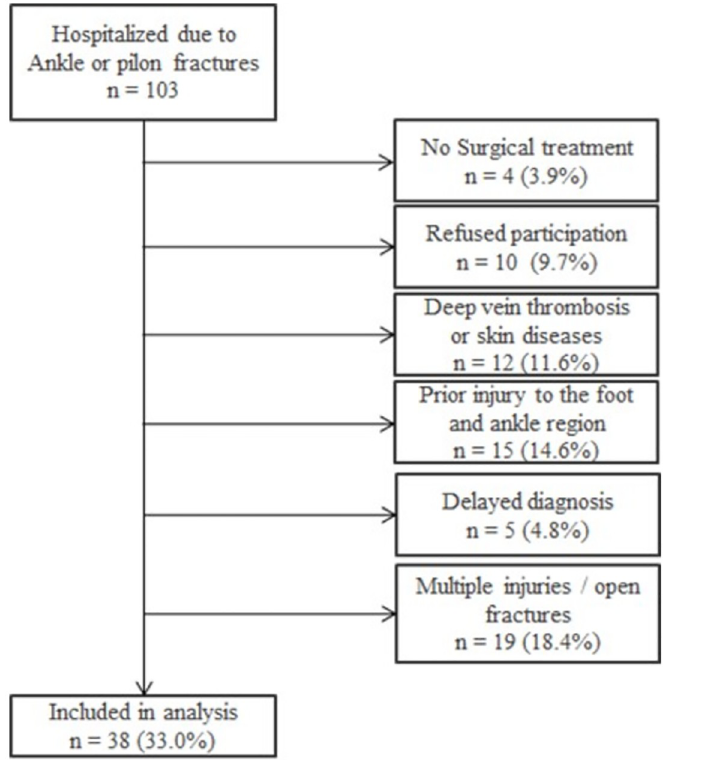
Fig 1. Flow chart of included and excluded